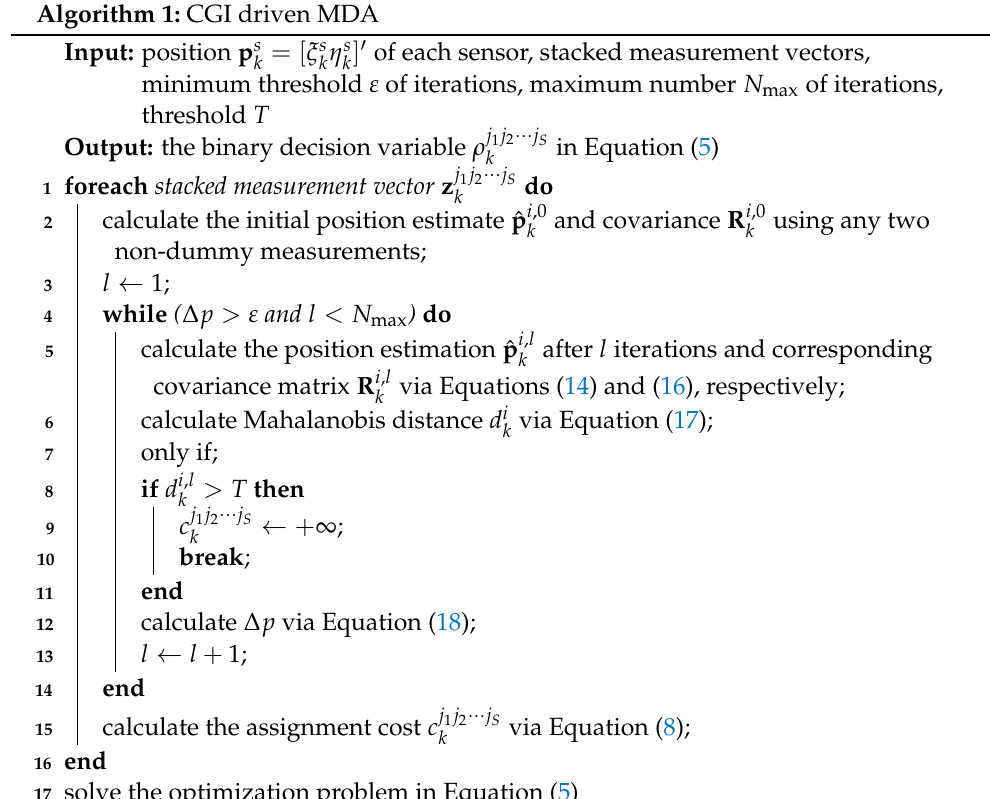
Algorithm 1: CGI driven MDA